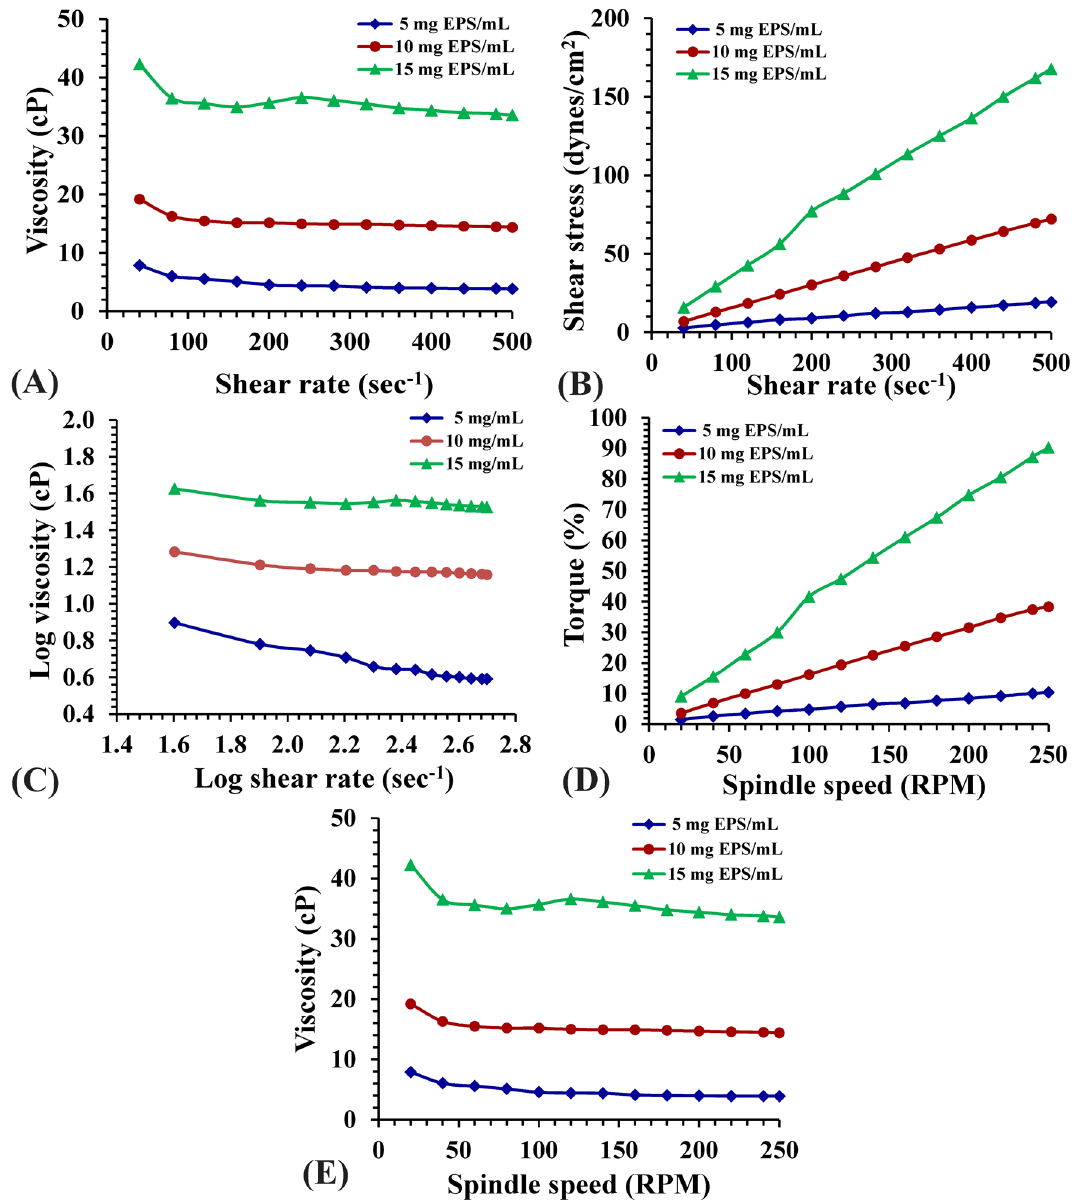
Figure 3. ( A ) Viscosity as a function of shear rate, ( B ) Flow curve of the shear stress vs. shear rate, ( C ) Log–log plot of the viscosity vs. shear rate, ( D ) Rheogram of the Torque vs. spindle speed and ( E ) Rheogram of the viscosity dependence of spindle speed (RPM) of aqueous solutions of extracted sodium alginate at concentrations 5, 10 and 15 mg control experiments were documented. On the other hand, all alginate supplementations decreased chlorophyll a and b contents below the control experiment while carotenoids content increased from 0.071 to 0.232 mg/g dry biomass with increasing the alginate supplementation from 0 to 0.5 g/L (Fig. 5A). In general, under this mixo- trophic nutritional mode, Chlorella vulgaris demonstrated marked increases in most measured growth param- eters, whereas, the magnitude of response followed dose response manner. The maximum stimulatory effect was induced by 0.3 g/L alginate hydrolysate supplementation for dry biomass, protein, carbohydrate contents record- ing values of 0.7 g/L, 179.222 mg/g dry weight and 620.332 mg/g dry biomass; respectively. Higher sodium algi- nate hydrolysate dose (0.5 g/L) induced nonsignificant increments in the dry biomass, protein and carbohydrate content recording 0.32 g/L, 131.215 mg/g dry weight and 433.143 mg/g dry weight; respectively. On the other hand, the specific growth rate increased in a dose—response manner, taking the bell shape response, achieving the maximum result (0.104 g/L/d) with 0.3 g/L alginate supplementation as illustrated in Fig. 4C. Figure 5C demonstrated the induced changes in the total phenolic content of chlorella vulgaris under this mixotrophic mode of nutrition. Data revealed significant increases in total phenolic contents relative to the con- trol level with increasing alginate hydrolysate concentration (18.315, 20.79, 27.697 and 26.468 mg/g); respectively.